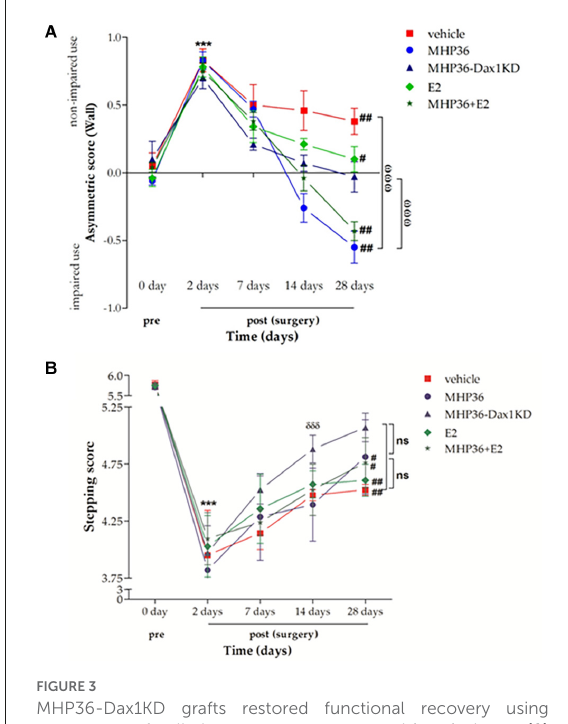
FIGURE3 MHP36-Dax1KD grafts restored functional recovery using spontaneous forelimb use asymmetry test and foot fault test. (A) A significant asymmetry on cylinder testing at 2 days post-MCAO was observed in all groups. MHP36-Dax1KD improved the functional recovery to pre-MCAO score ( ∗∗∗ p < 0.001 pre-MCAO vs. 2 days post-MCAO in all groups; # p < 0.05, ## p < 0.01 pre- MCAO vs. 28 days, ωωω p < 0.001 MHP36 and MHP36+E2 vs. vehicle and MHP36-Dax1KD at 28 days post-MCAO, repeated measures ANOVA; n ≥ 4). (B) A significant stepping error, on the ladder rung test, at 2 days post-MCAO was observed in all groups. MHP36-Dax1KD grafts not only improved recovery at 28 days (n.s. vs. pre-MCAO) but also accelerated recovery of limb function at 14 days ( ∗∗∗ p < 0.001 pre-MCAO vs. 2 days post-MCAO in all groups; # p < 0.01, ## p < 0.001 pre-MCAO vs. 28 days post-MCAO; δδδ p < 0.001 2 days post-MCAO vs. 14 days